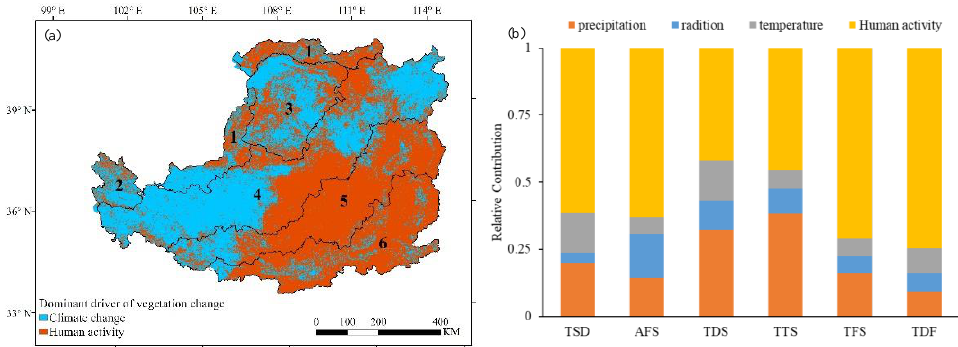
Figure 6. ( a ) Spatial pattern of dominant driver of variations of NPP on the LP. The numbers on the pixels represent six sub-regions on the LP: (1) Temperate steppe desert (TSD), (2) alpine forest – steppe (AFS), (3) temperate desert – steppe (TDS), (4) temperate typical steppe (TTS), (5) temperate forest – steppe (TFS), (6) temperate deciduous forest (TDF). ( b ) Relative contribution of climate factors and human activity to variations of NPP in sub-regions on the LP.